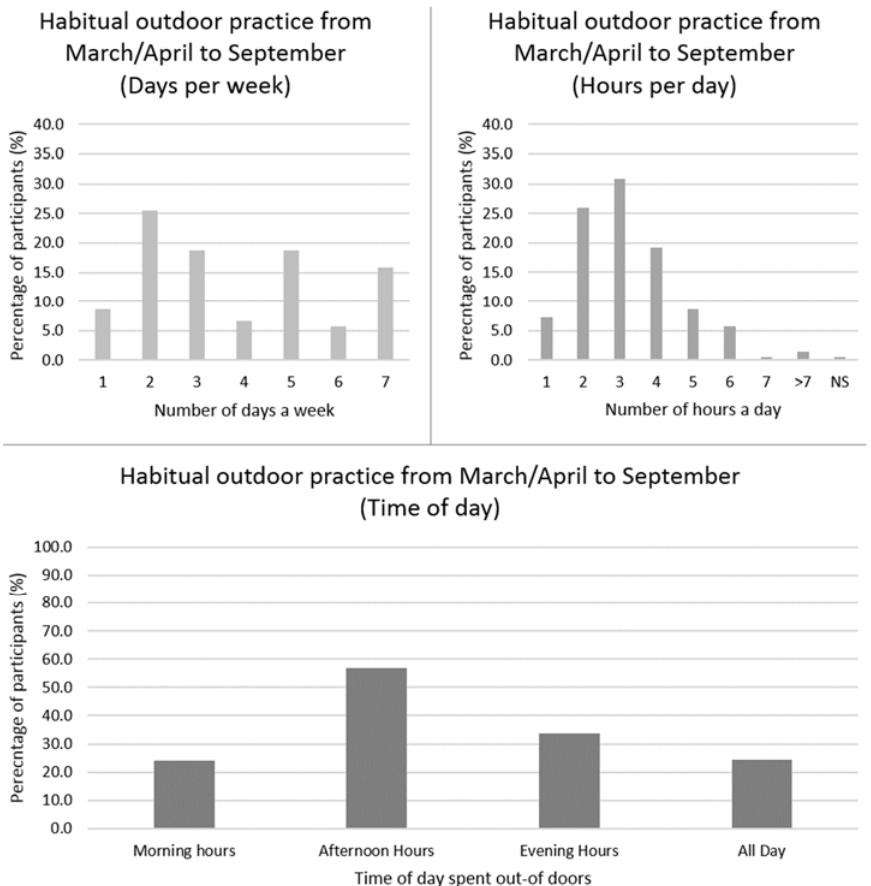
Figure 3. UK participants’ frequency of time spent outdoors in daylight from March/April to September ( n = 208, one participant did not respond). Top left: Habitual number of days per week spent outdoors. Top right: Habitual number of hours per day spent outdoors. Bottom: Habitual time of day spent outdoors, not indicative of one single day; participants were able to select all relevant answers. Abbreviations: Not Specified (NS); Percentage (%).